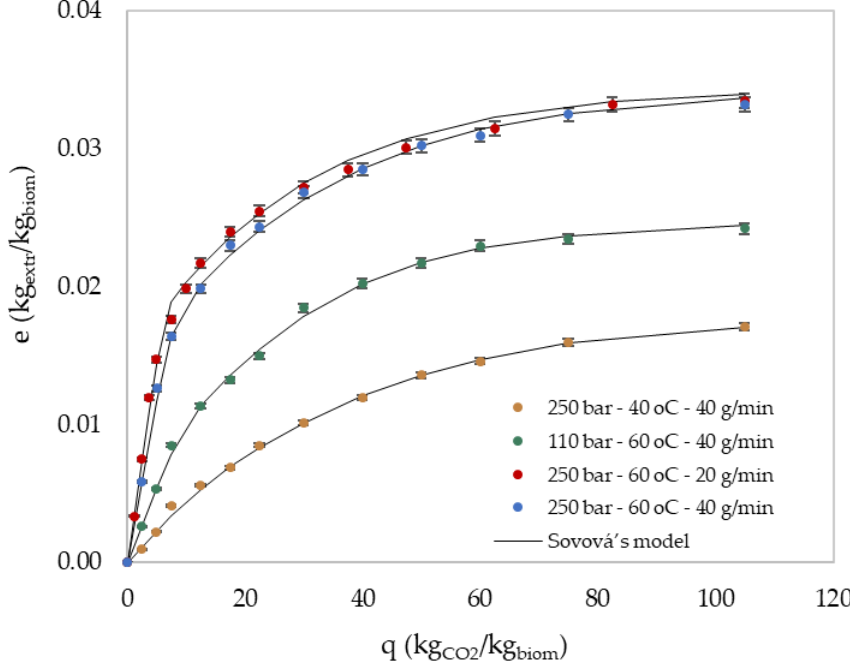
Figure 7. Effect of temperature (blue & yellow), pressure (blue & green), and solvent flow rate (blue & red) on yield (kg extr /kg biom ) versus specific amount of solvent (kg CO2 /kg biom ). Correlation results with Sovová’s model are also included. The experimental standard deviation was expressed using the error bars. Table 3. Optimal estimated parameter values of the Sovová model for the C. vulgaris SFE.